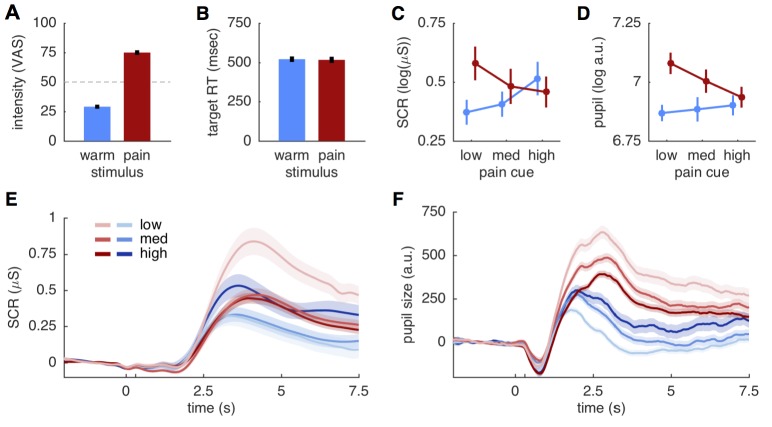
Behavioral and physiological results.(A) Intensity ratings reported at the end of each block for warm and painful stimuli, respectively. Intensity ratings were significantly higher for pain stimuli (t(27) = 20.9; p<0.001) and correspond well to the stimulation levels chosen during calibration (30 and 75). ‘Pain threshold’ was marked at the center (50) of the visual analogue scale (VAS) used for these ratings. Error bars in all plots show the standard error of the mean. (B) Target reaction time did not differ between stimulation intensities (t(27)=0.51; p=0.61). (C) Skin conductance responses (SCR) for pain (red) and warm (blue) stimuli. SCR responses reflect the pattern hypothesized by the predictive coding model. (D) Pupil dilation amplitudes shows the same response pattern as SCR, also supporting the predictive coding model. (E) Evoked skin conductance responses (SCR) for warm (blue) and painful (red) stimuli are plotted for each condition and followed the rank order hypothesized by the predictive coding model. (F) Pupil diameter responses plotted using the same groupings as in (D). SCR and pupil traces are aligned to cue onset at 0 s, stimulus onset is at 300 ms (unlabeled tick mark), and shaded areas indicate standard errors.